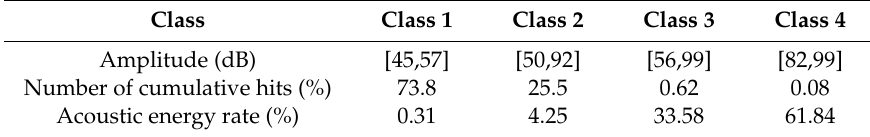
Figure 12. ( a ) Representation of events in amplitude / deformation, ( b ) cumulative acoustic energy of the different classes for the 0° specimen types.